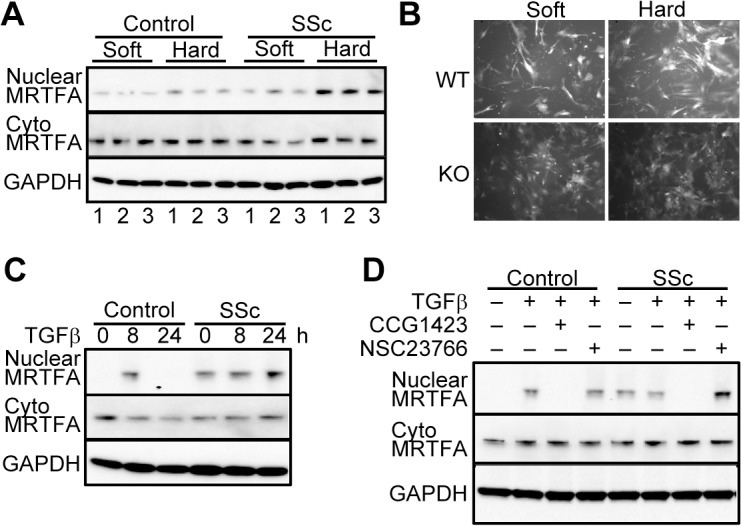
Stiff surfaces and TGFβ induce MRTF-A nuclear accumulation.SSc and control dermal fibroblast lines (both N = 3) were cultured on 6 well plates with collagen type I coated soft substrates (5 kPa Softwell), or hard substrate (50 kPa). B. Induction of collagen transcription on hard surfaces requires MRTF-A. Mouse fibroblasts from wild type (WT) and loss-of-function (KO) mice with collagen promoter driving GFP were cultured on fibronectin coated soft and hard surfaces. Pictures taken 24 hours after plating. Fluorescence was quantified using ImageJ. The numbers of cells in each image was counted (S4 Fig) to determine the luminance per cell. C.&D. Normal control fibroblasts and SSc fibroblasts were cultured without serum for 16 hours then treated with TGFβ (4 ng/ml) for 0, 8 and 24 hours or treated with either saline or TGFβ (4 ng/ml) with or without CCG1423 (10μM) or NSC2376 (50 μM). Proteins (20 μg) from cytoplasm and nuclei were extracted using NE-PER Nuclear Protein Extraction Kit and separated on 4–12% gradient gel and visualized using MRTF-A antibody.